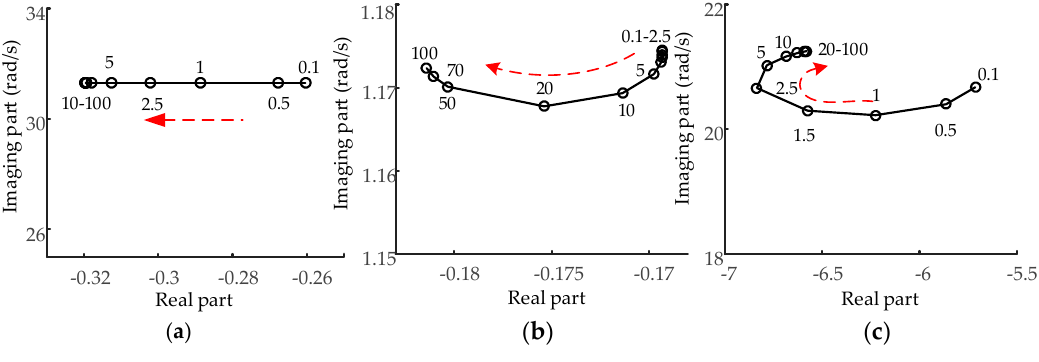
Figure 10. Impact of the current controller parameters: T R ( a ) Tor-1 mode ( b ) Tor-2 mode ( c ) Electro mode.